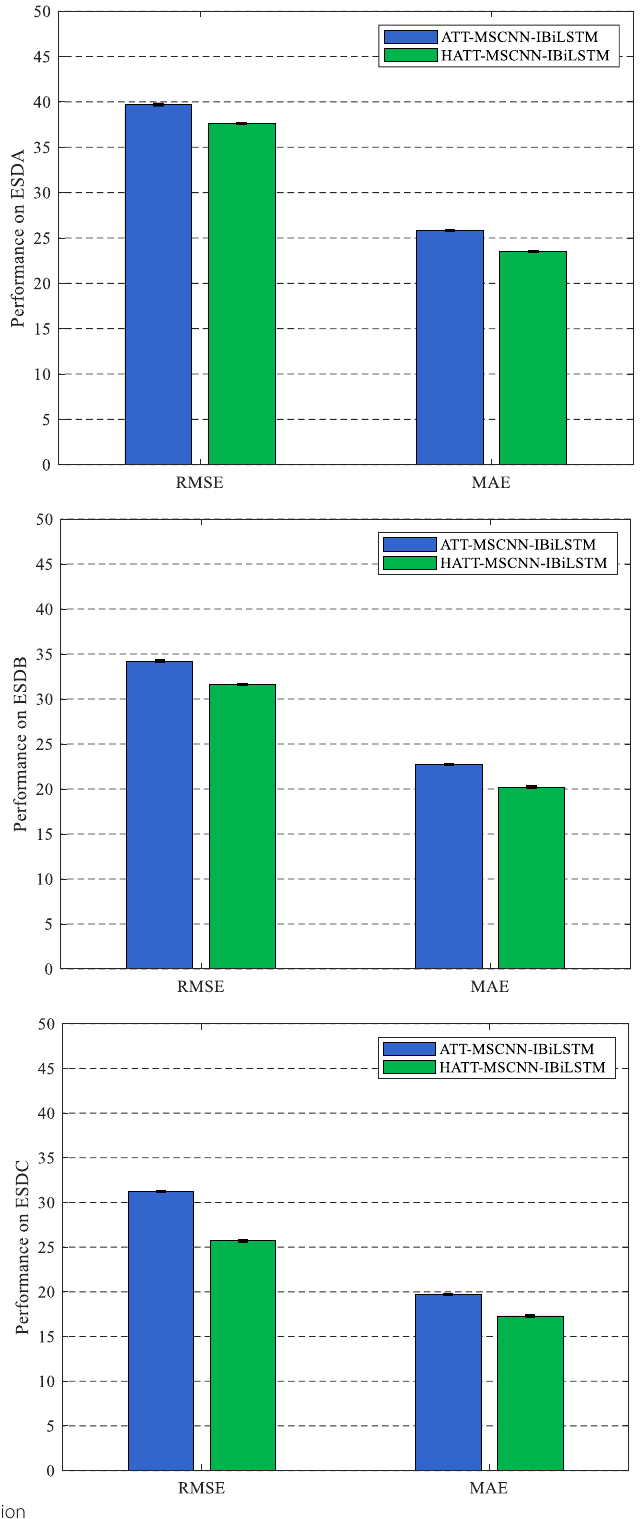
Fig. 15 Analysis on hybrid